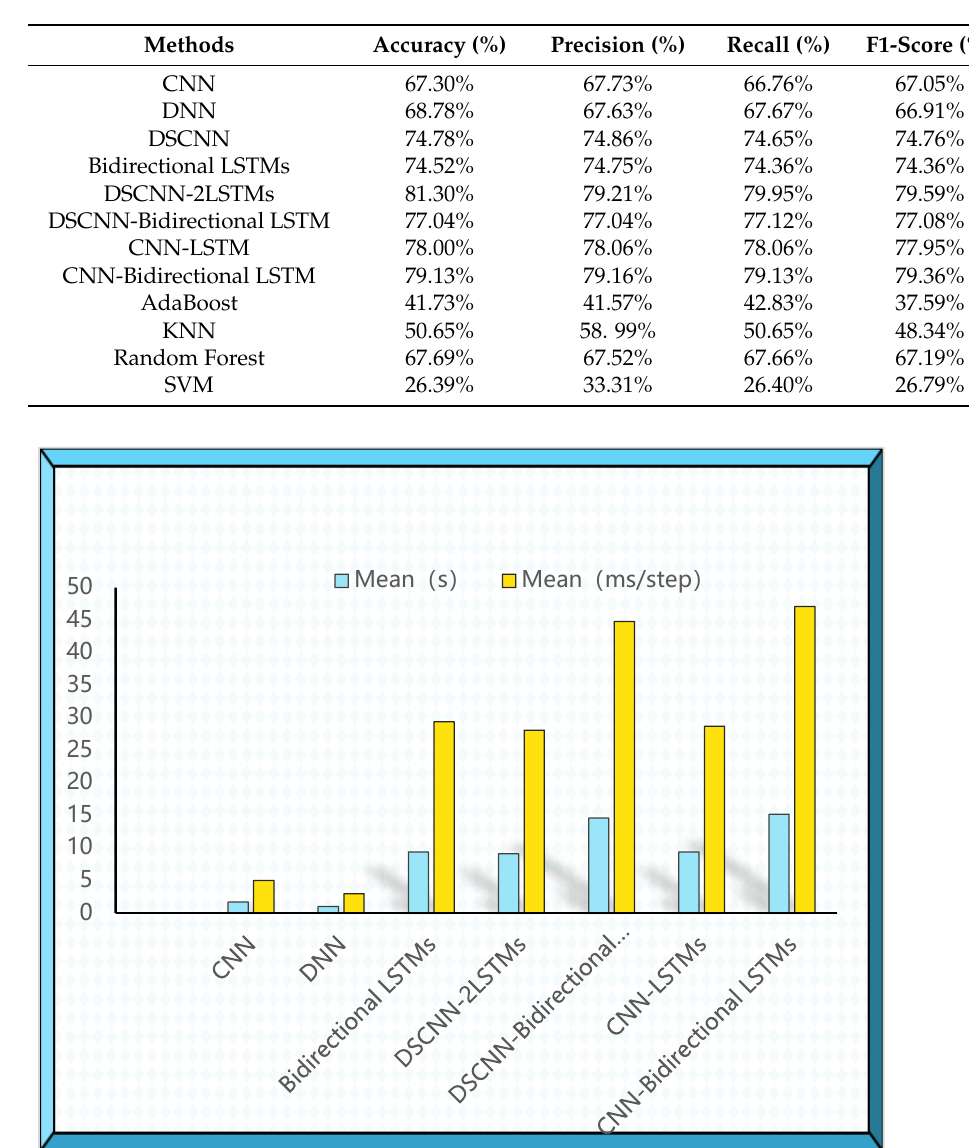
Table 10. The Performance of DSCNN-2LSTM and other models on the five-class classification task.